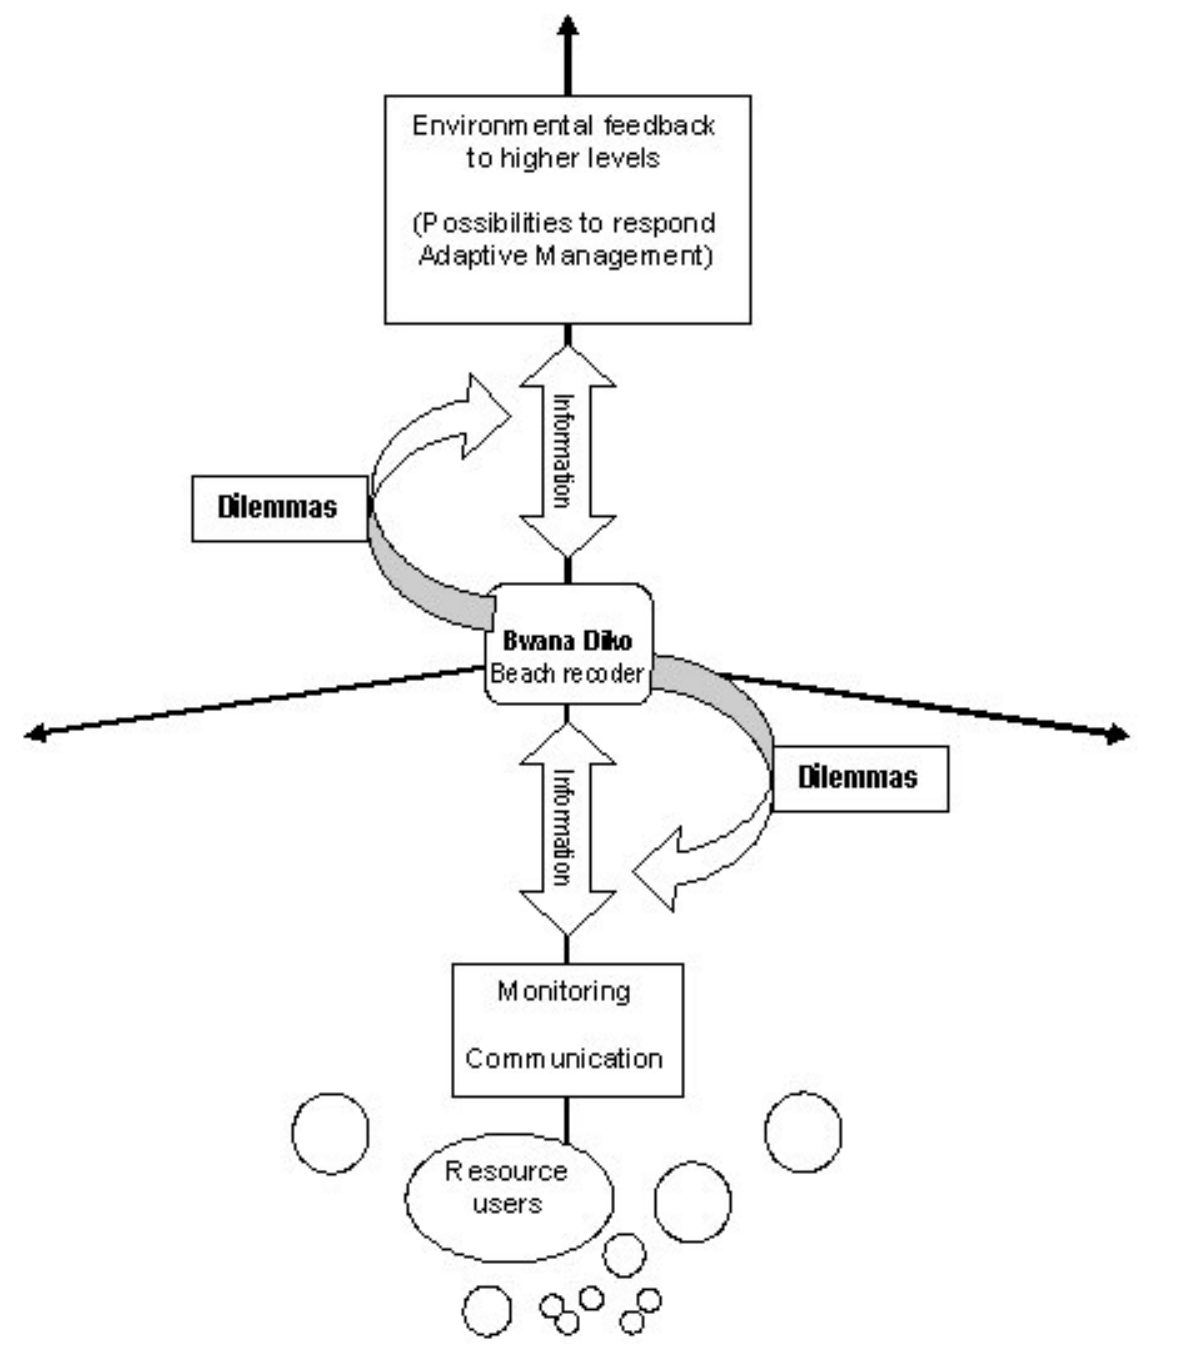
Fig. 3. Position of the Bwana Dikos and the dilemmas in the organizational structure, indicating links and feedbacks between